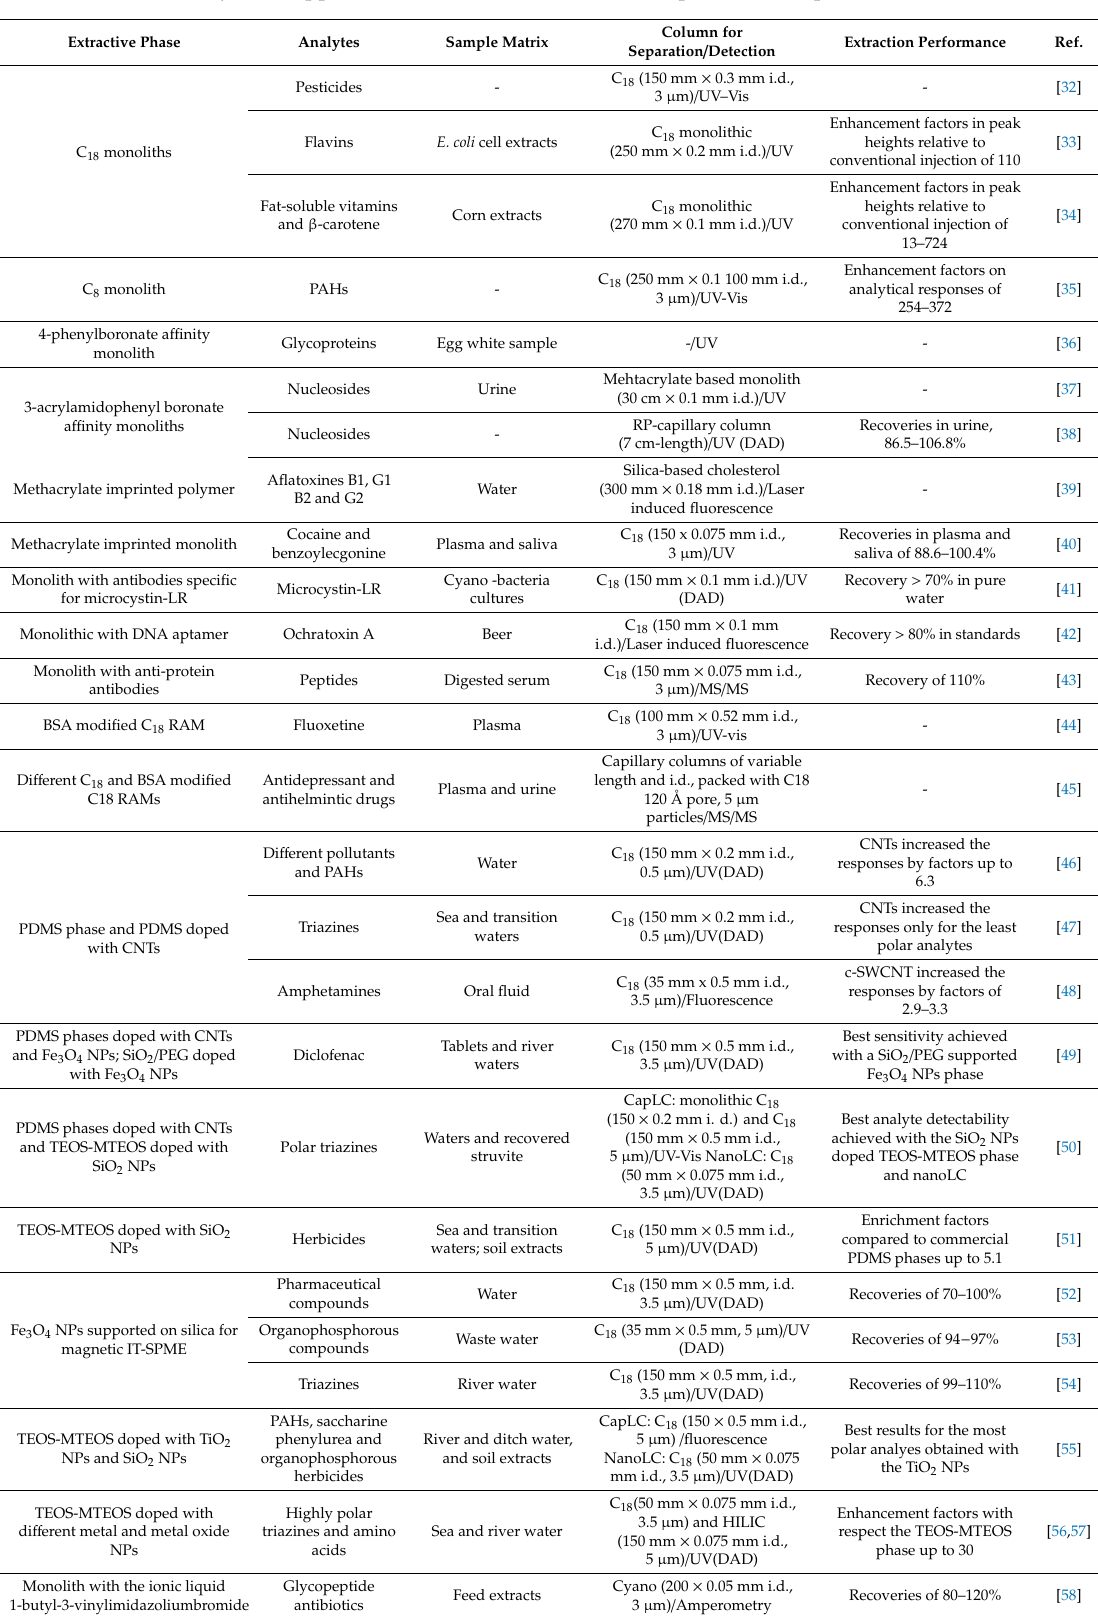
Table 1. Summary of the applications of IT-SPME with extractive phases developed for miniaturized LC. Extractive